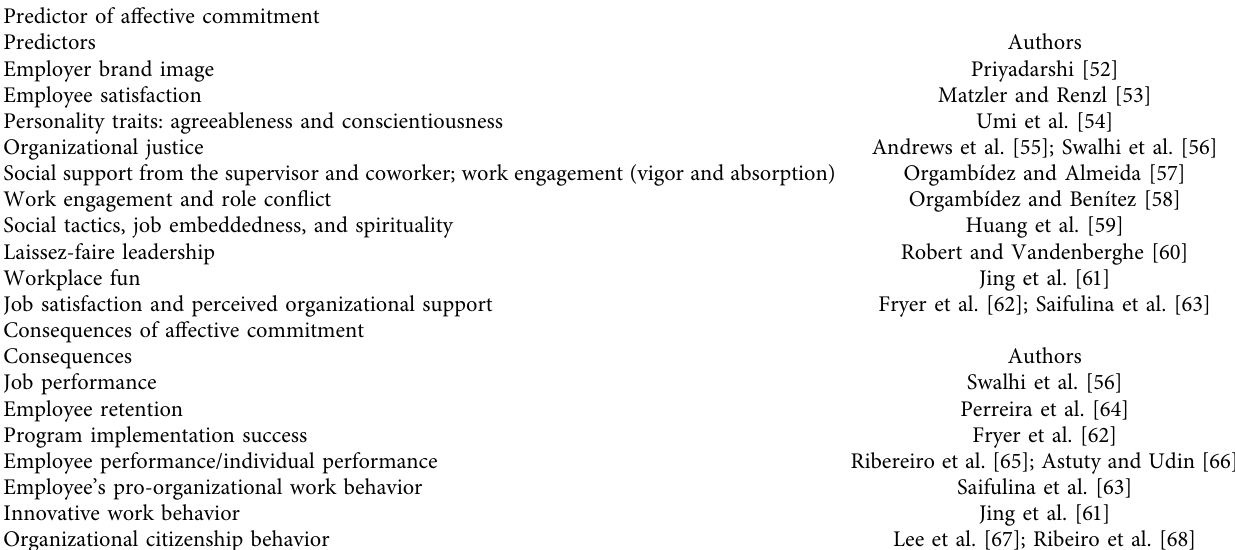
Table 1: Predictors and consequences of affective